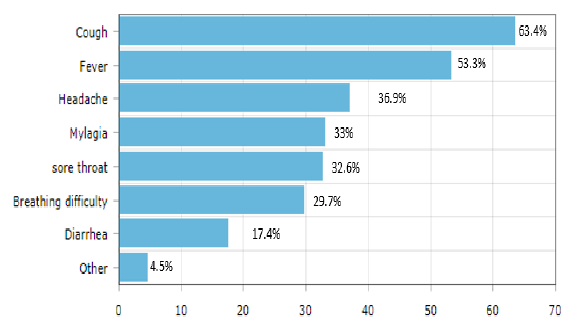
Figure 4 : Covid-19 symptoms